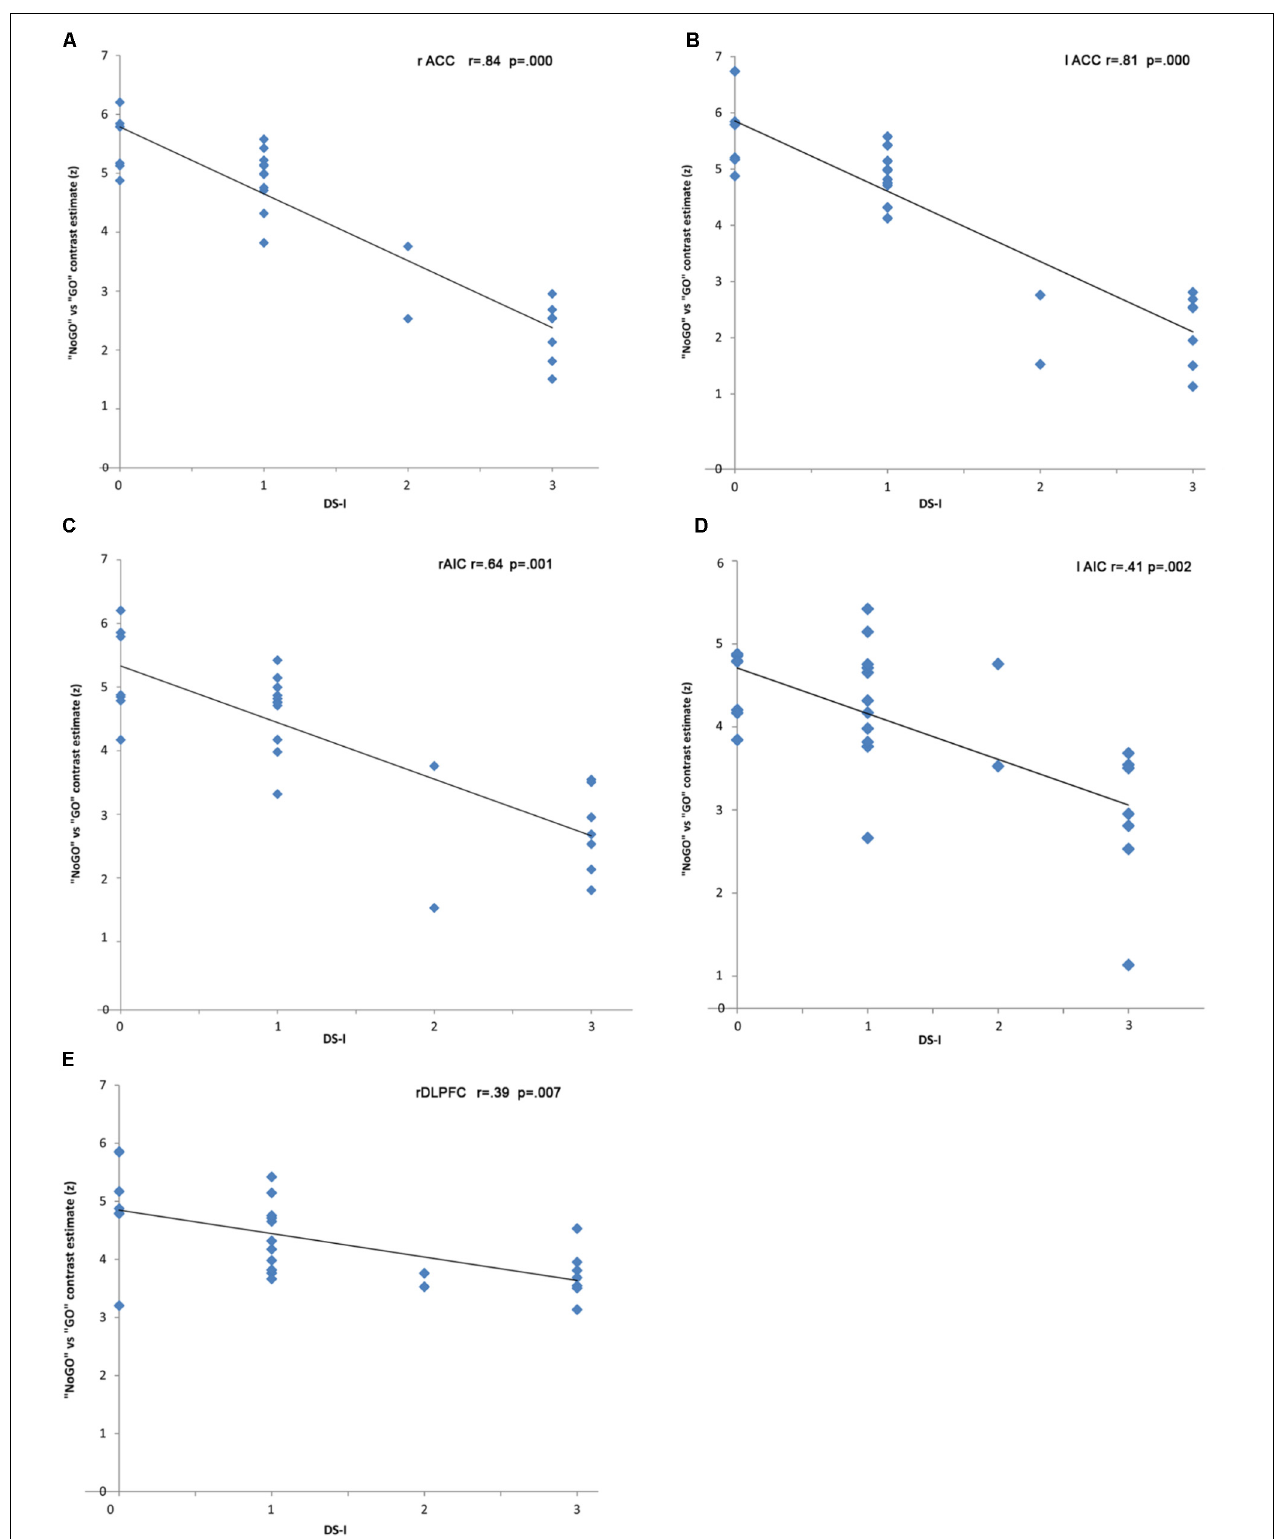
FIGURE 3 | Strength of the fMRI responses (percent change of the BOLD signals) in NoGO trials.